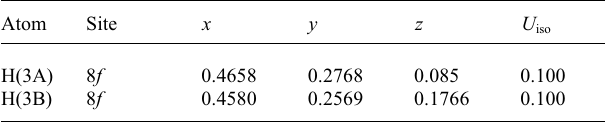
Table 2. Atomic coordinates and displacement parameters (in Å 2 ) .